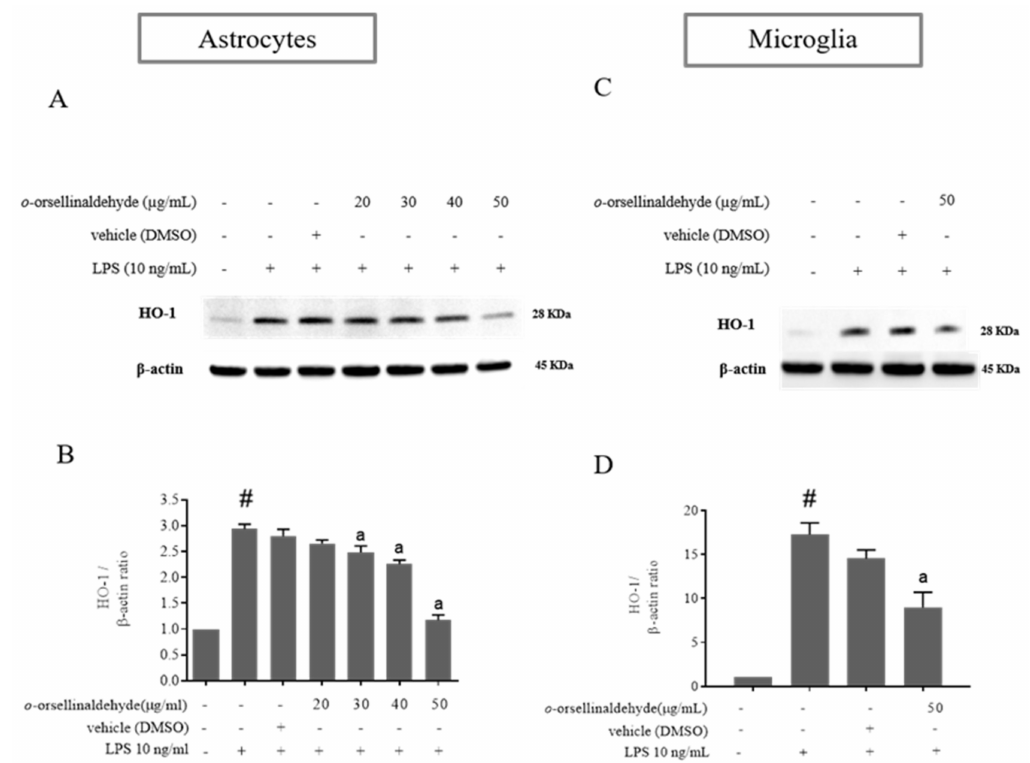
Figure 5. o -Orsellinaldehyde counteracts LPS-induced HO-1 protein expression in astrocytes and microglia cells. Cells were incubated with the indicated concentrations of o -orsellinaldehyde for 30 min before treatment, and with LPS (10 ng/mL) for 24 h. The cell pellet was collected for HO-1 measurement by Western blot. ( A ) Representative image of iNOS Western blotting in astrocytes. ( B ) Representative image of HO-1 Western blotting in microglia ( C ) Densitometry plot of Western blots carried out in astrocytes. ( D ) Densitometry plot of Western blots carried out in astrocytes. Results are shown as the mean ± SD of four independent experiments. Statistically significant differences ( p ≤ 0.05) of LPS compared to the control condition are expressed as a “#”. Statistically significant differences ( p ≤ 0.05) between LPS conditions are expressed with an